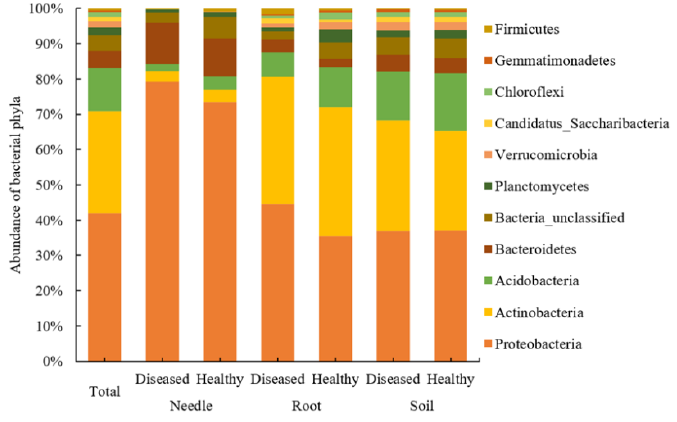
Figure 1. The relative abundance of bacterial phyla (% of the total number of reads) in healthy and diseased samples in the needles, roots, and soil of Pinus thunbergii .